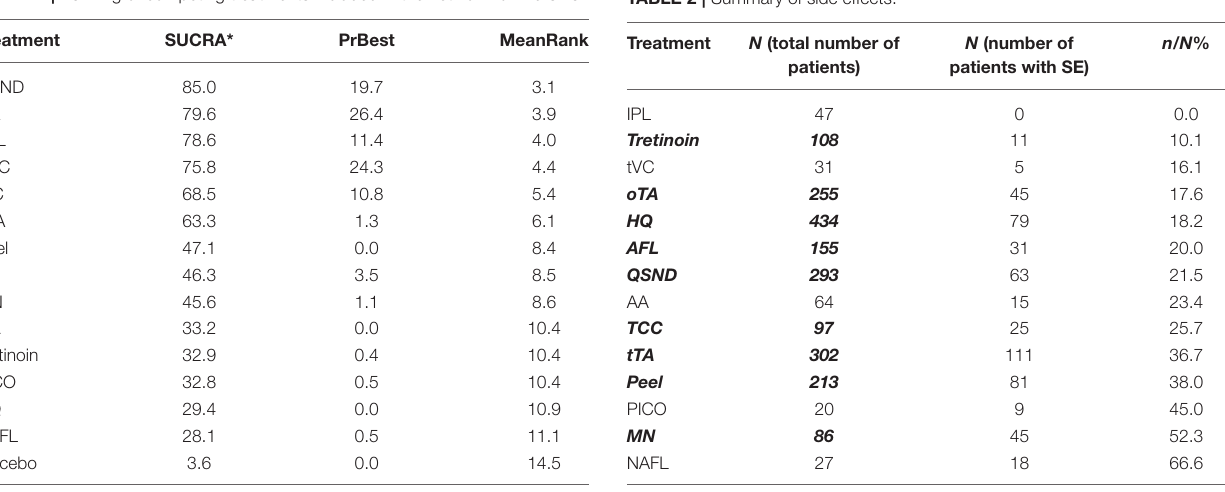
Frontiers in Medicine |